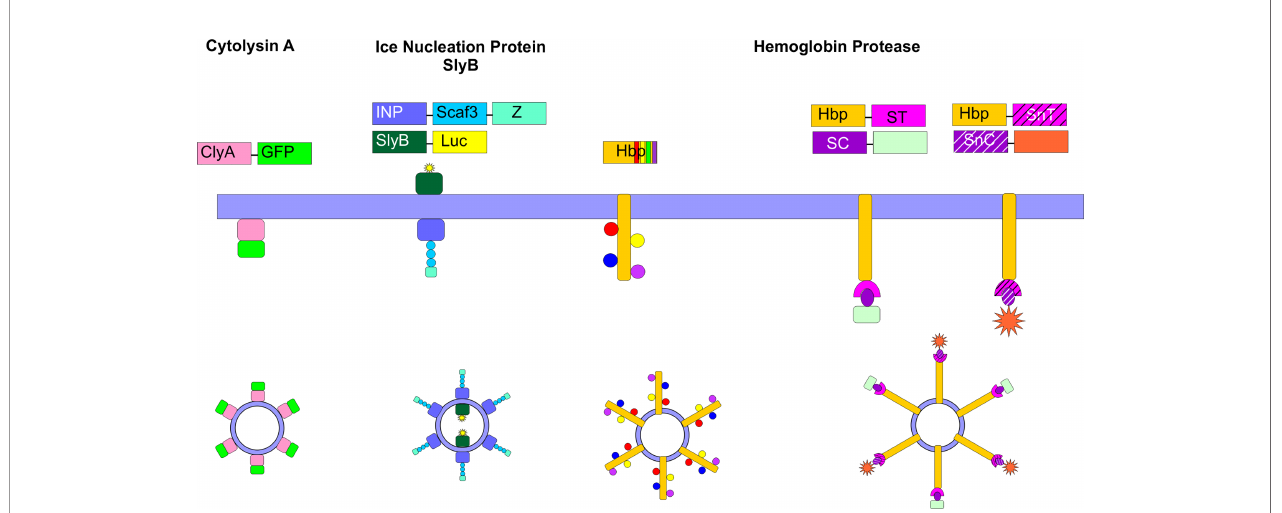
FIGURE 5 | Surface Engineering of OMVs. Several genetic strategies have been used to localize certain proteins on the surface of OMVs. Fusion proteins between cytolysin A (ClyA) and several cargos, including GFP have been created in E. coli . Ice nucleation protein (INP) was used to tether an antibody on the surface of the OMV by creating a fusion between INP, a cohesin-containing Scaf3 domain, and an antibody-binding Z-domain. Simultaneously, SlyB was used to localize luciferase to the OMV lumen. Up to four bacterial antigens were tethered to the surface of OMVs using the hemoglobin protease (Hbp). This protein was also used in combination with the SpyCatcher/Tag and SnoopCatcher/Tag systems to display heterologous proteins on the OMV